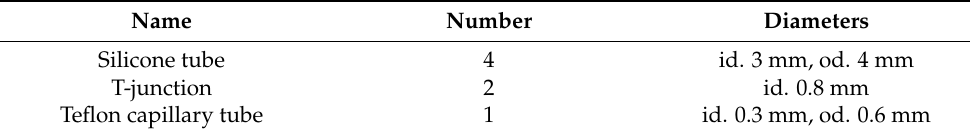
Figure 2. Component and assembly diagram of the droplet generator. ( a ) Shows the connection state of the symmetrical tubes during generation of droplets, ( b ) shows the core part of the material, ( c ) indicates the beginning state after connecting the syringe pump. Table 1. Table with the characteristics of the